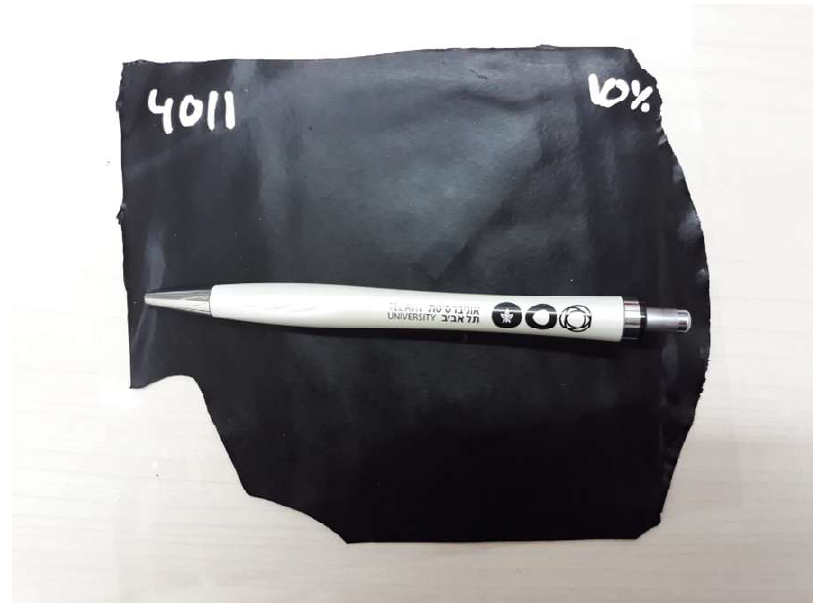
Figure 1. Vulcanized plate of VMQ with 10 wt.% of MWCNT. Pen to scale.